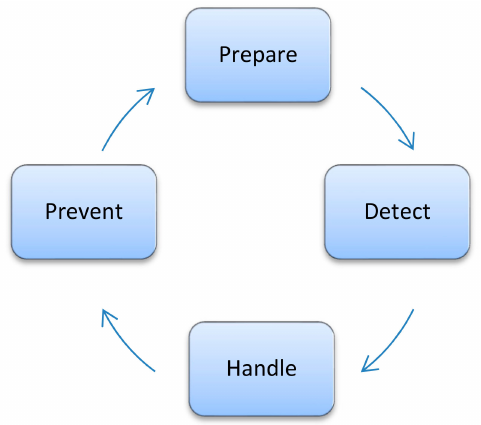
Figure 3. Four key stages of security incident management (SIM)